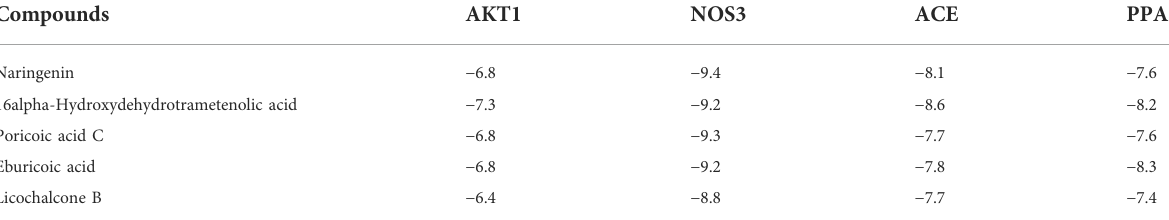
TABLE 5 Docking energy of the active ingredients and targets (kcal · mol − 1 ).